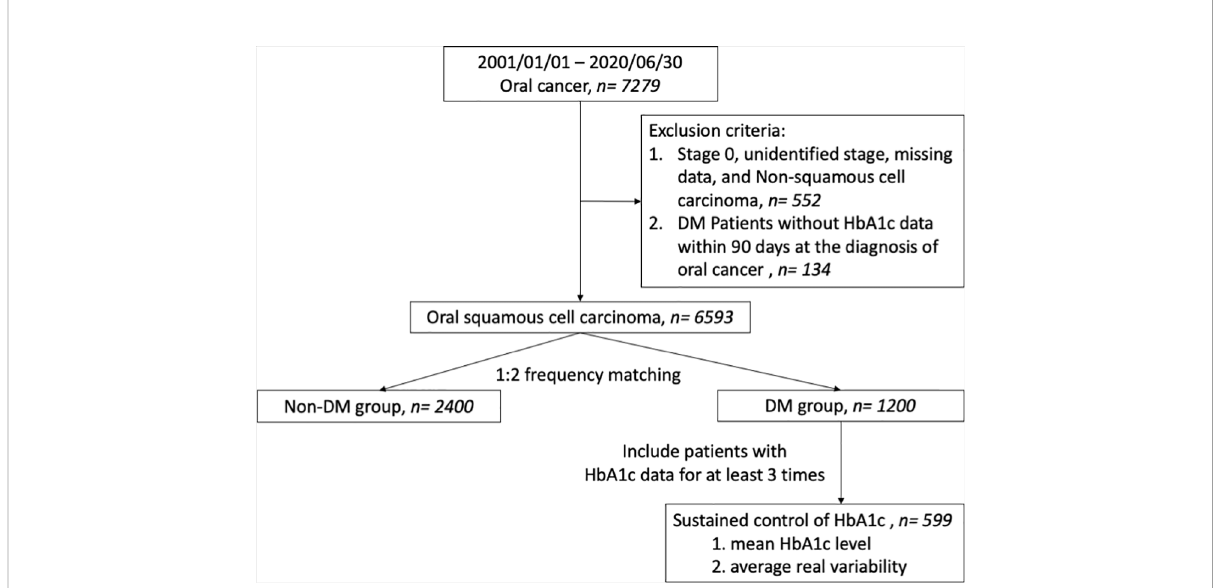
FIGURE 1 Flow diagram illustrating the cohort study design in patients with oral cancer. DM, diabetes